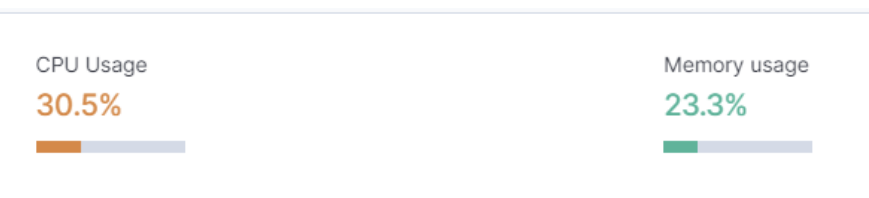
Figure 8. Mean CPU and memory usage (normal platform usage).